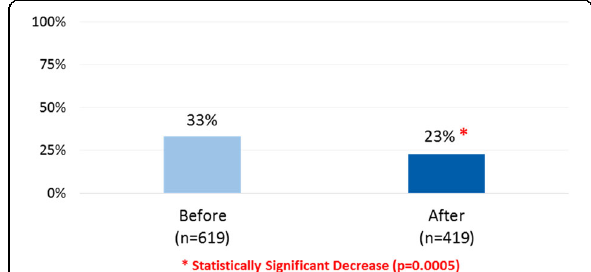
Fig. 4 Appendectomy rates before vs. after protocol initiation. There were significantly fewer patients treated with surgery after the implementation of the pathway